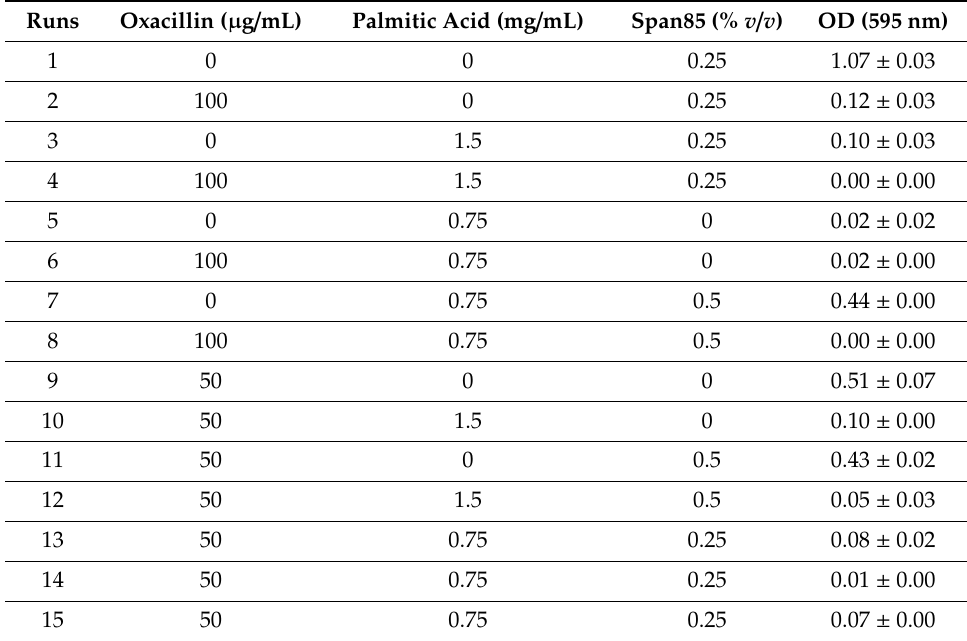
Table 2. Box–Behnken experimental design matrix with experimental values of the cell growth of the ∆ agr